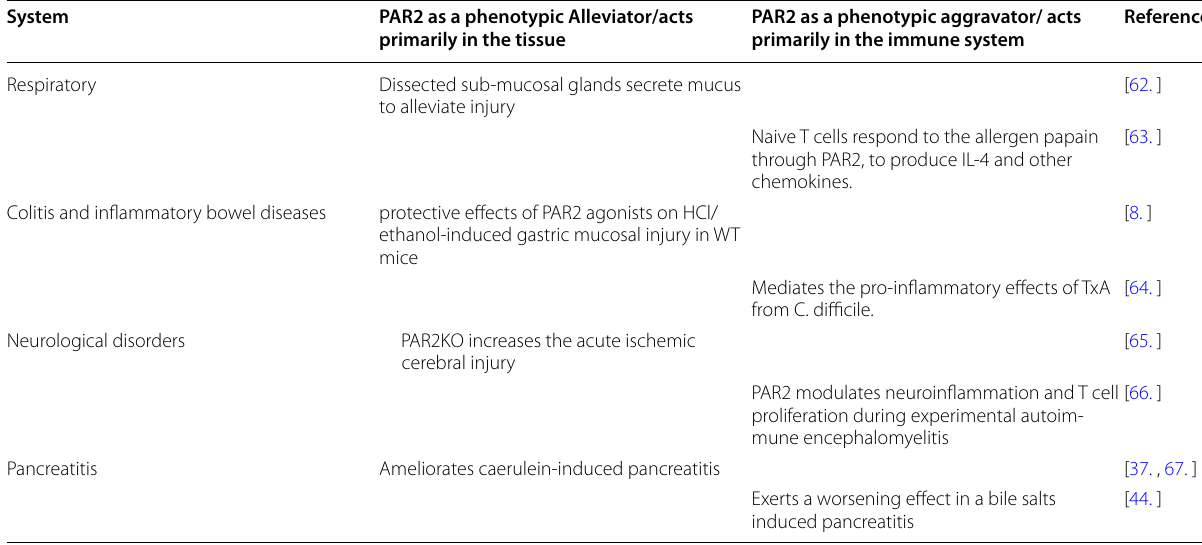
Table 1 Par2 modulation experiments conducted in the same tissue assigned according to the observed phenotype. Note that in the cases in which the damage is mediated by the immune system, Par2 has an aggravating role, while in the cases in which the damage is inflicted directly to the tissue, Par2 activation alleviates the